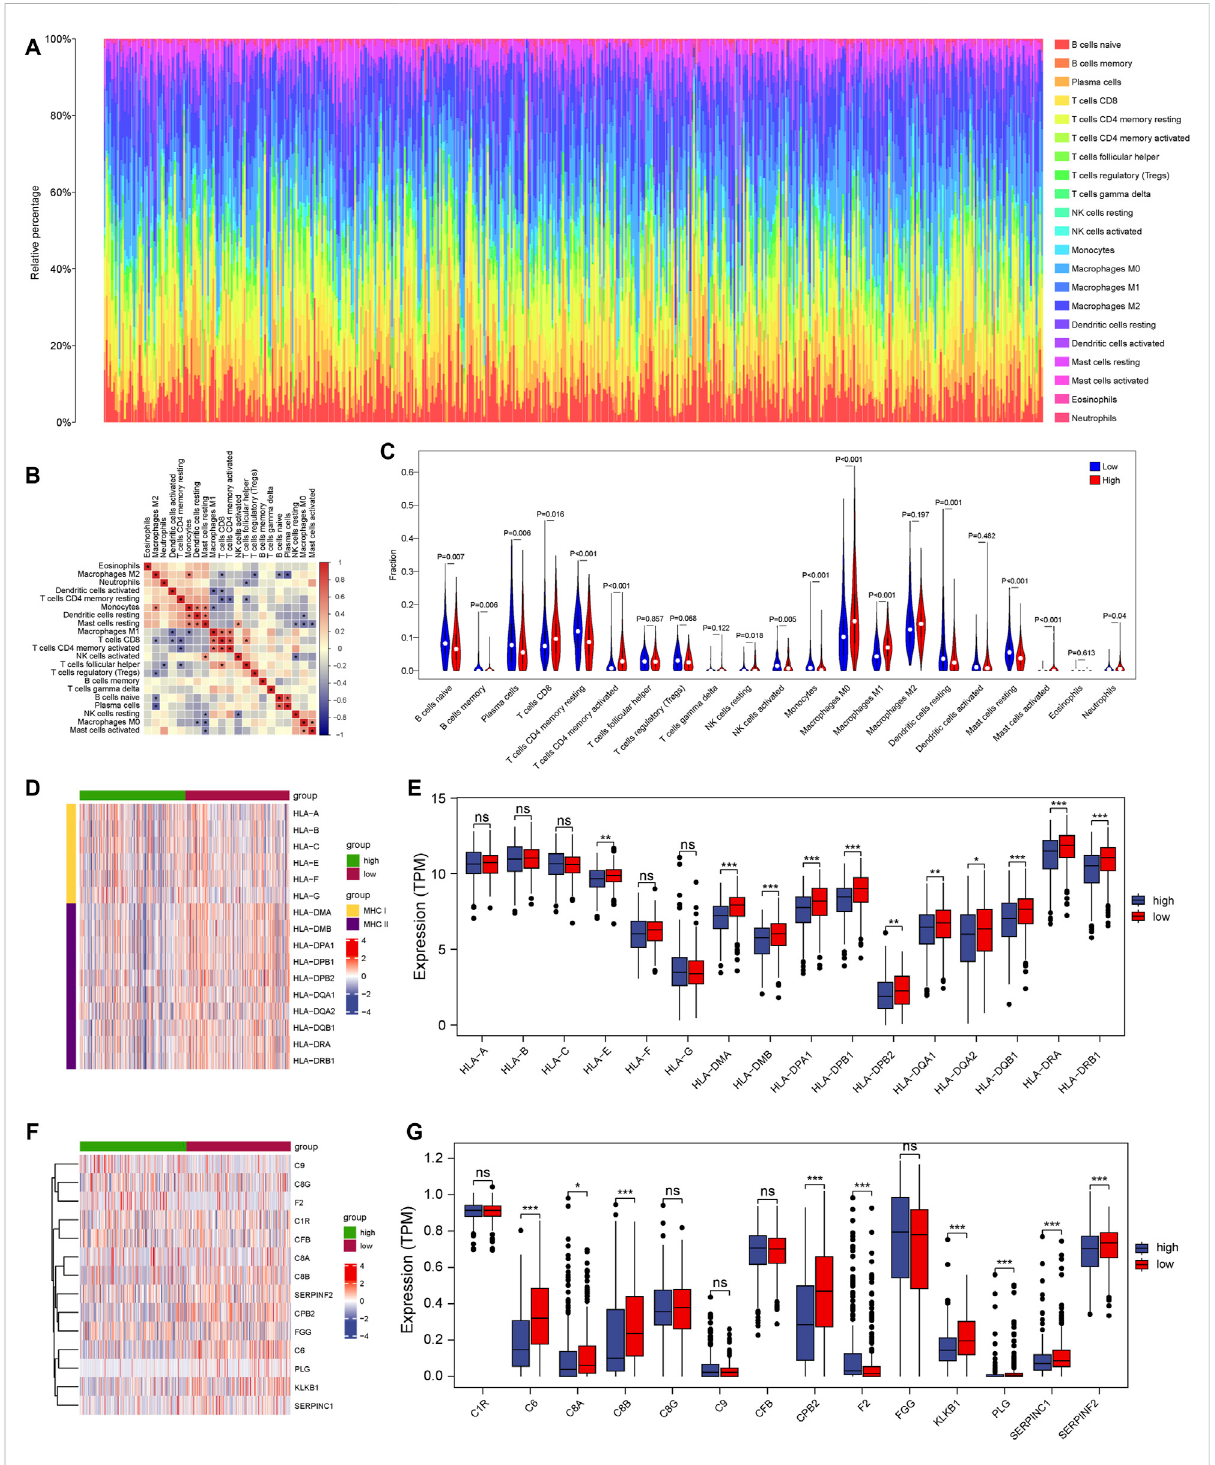
FIGURE 8 Immune in fi ltration in the two risk groups (A) The panorama of 22 immune cell in fi ltrates (B) Correlation analyses of 22 immune cell types (C) Differences in the immune cell in fi ltration between high-and low-risk groups (D,E) Differential expression of HLA gene family between the two risk groups (F,G) Differentialexpressionofcomplement-relatedgenesinthetworiskgroups.*represents p < 0.05;**represents p < 0.01;***represents p < 0.001; ns represents no signi fi cant difference ( p >